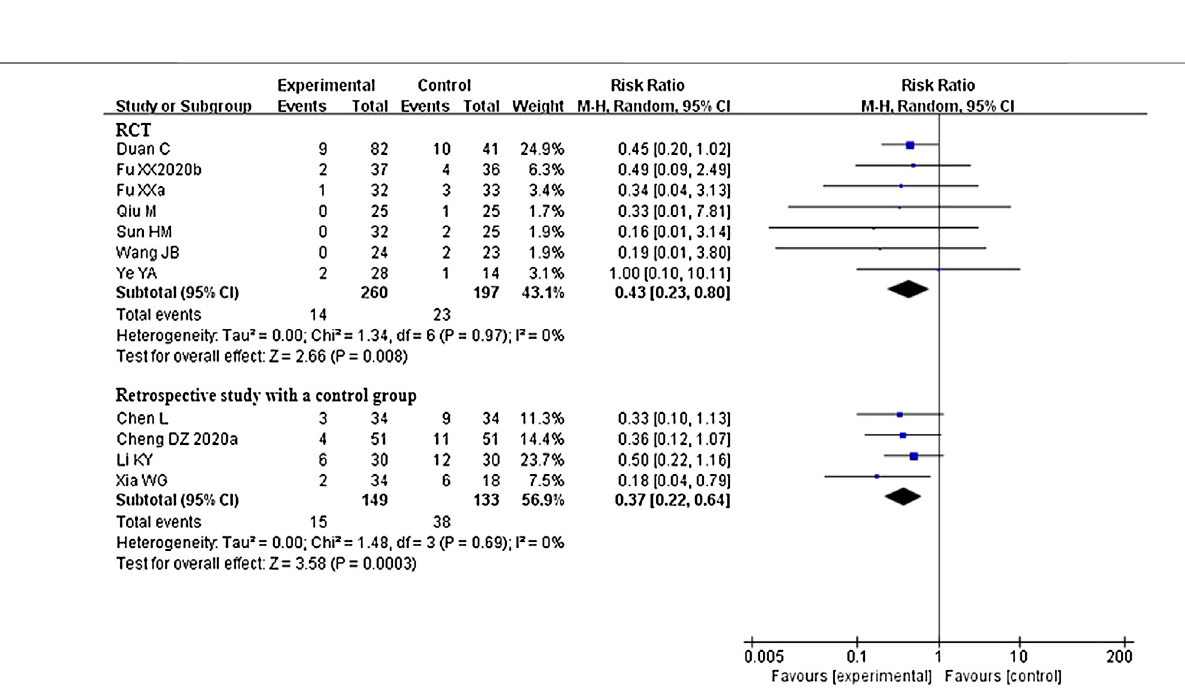
Frontiers in Pharmacology |